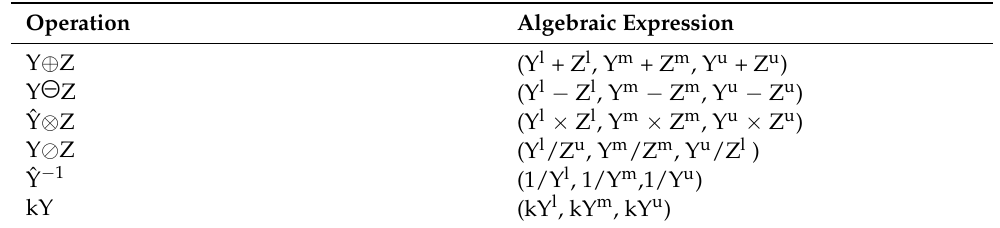
Table 3. Fuzzy Operations.